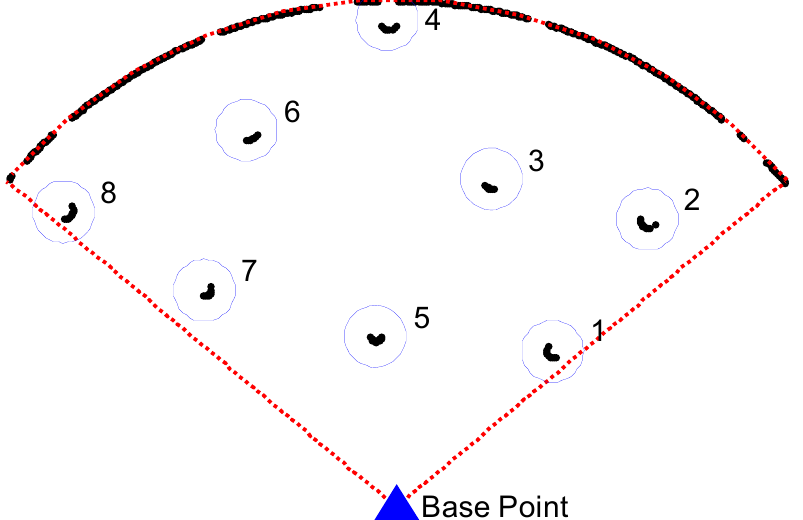
Figure 4. The scanning and clustering result of the